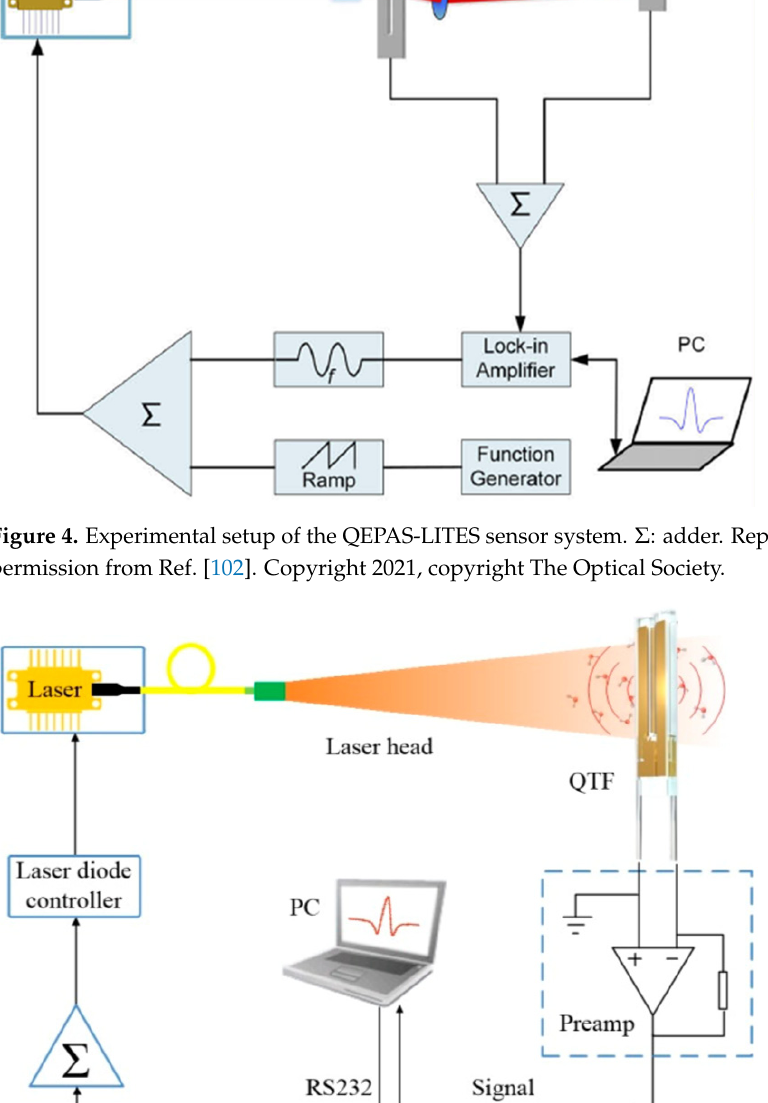
Figure 6. ( a ) S-QEDS sensor system configuration. ( b ) QEPAS sensor system configuration. ( c ) LITES sensor system configuration. QTF: quartz tuning fork; FC: fiber collimator; PC: personal computer. Reprinted/adapted with permission from Ref. [105]. Copyright 2021, copyright The Op- tical Society. 4. Multi-QTF-Based LITES Sensor In 2015, Ma et al. reported multi-quartz-enhanced photoacoustic spectroscopy (M-QEPAS) [111], which used two QTFs to achieve a 1.7 times signal enhancement with re- spect to the single QTF-based QEPAS method under the same operating conditions. Simi- larly, they extended this idea to LITES. A multi-QTF-based LITES sensor system was demonstrated by them in 2020 [112]. The experimental setup was shown in Figure 7. The metal film with high reflectivity at the optimal laser focusing position of the QTFs was re- moved, in order to improve the laser absorption and transmission. The detailed etching method can be obtained from Ref. [112]. A DFB diode laser with output power of 10.62 mW was used to detect C 2 H 2 at 1530.37 nm. The collimated laser beam passed through the gas